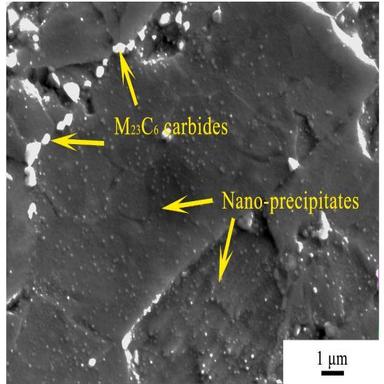
An SEM micrograph of ODS Eurofer showing M23C6 carbides and nanoprecipitates.